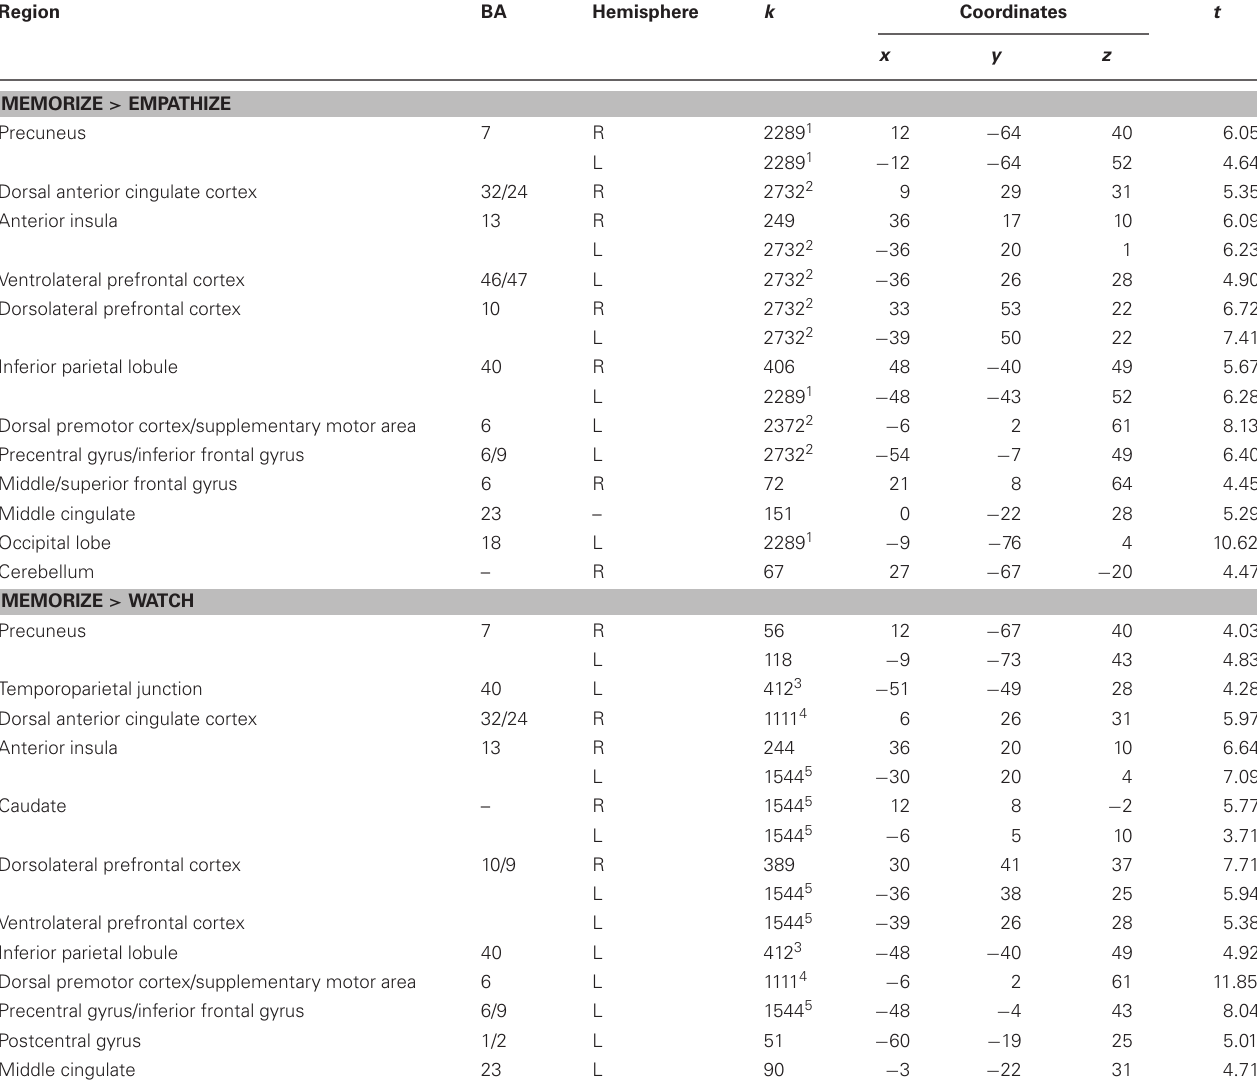
Table 6 | Neural regions that were more active under cognitive load compared to empathize (collapsed across emotions) and more active under cognitive load compared to watch (collapsed across